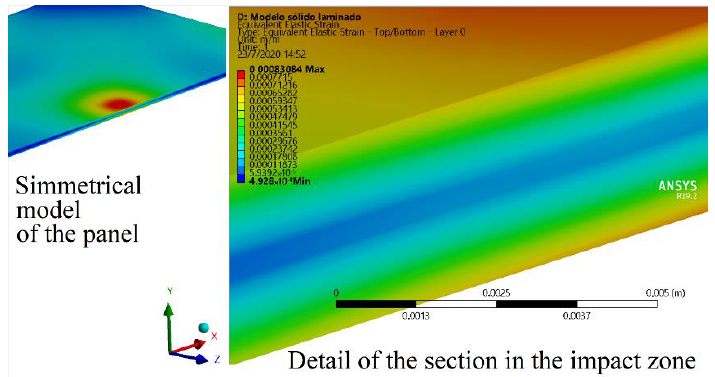
Figure 8. FEM model. Figure 8. FEM